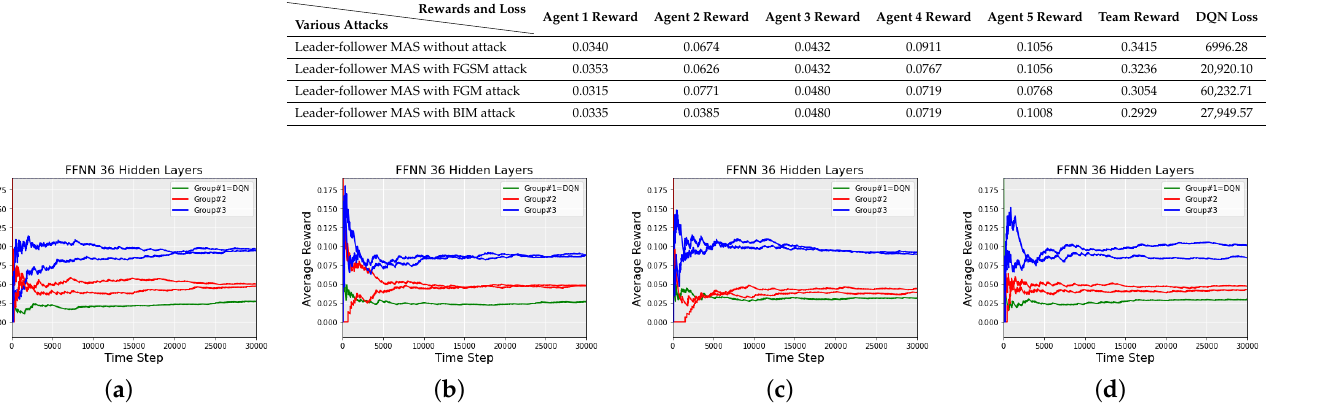
Table 3. Comparison of each agent’s average reward and DQN loss of a heterogeneous MAS, including N = 5 agents in P = 3 different clusters, during 30,000 time steps by considering time- delay and distance-based reward under FGSM, FGM, and BIM adversarial attacks.